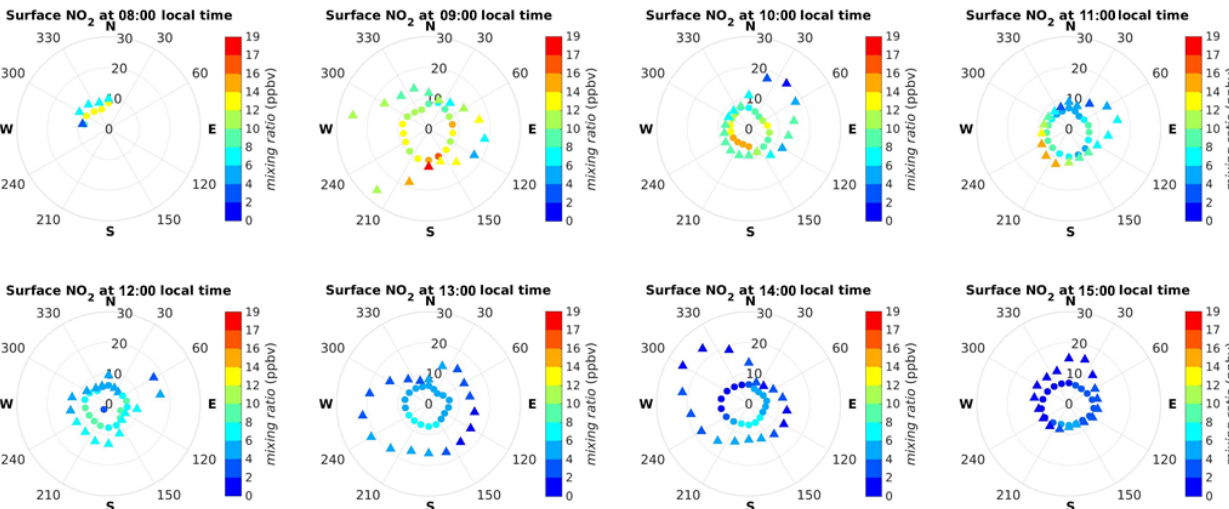
Figure 10. Polar plots of NO 2 within the surface layer (0–200m height) for 11 May 2019. Please note that these polar plots extend over a direction perpendicular to those shown in Fig. 8. Here, circles are used for the UV (shorter horizontal light path) and triangles for the VIS (larger horizontal light path). Both symbols stand for the mean horizontal light path within the surface layer at each spectral region.